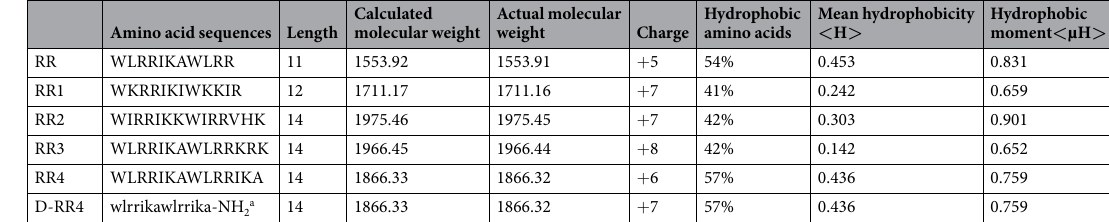
(Table 2). The reason for this minor discrepancy in antimicrobial activity between RR4 and D-RR4 against dif- ferent bacterial isolates is not clear. Previously it was reported that membrane-targeting antimicrobial peptides work without the need for receptors and therefore D isomers have similar antimicrobial activity to L isomers 17 . However, there are several studies that have reported that D isomers demonstrated different antimicrobial responses than their L isomer counterparts against different bacterial isolates. This may be due to the fact that the backbone of D and L isomers of helical AMPs, in three-dimensional space, have opposite rotations and therefore their side chains will have differing topologies 18 . A possible alternative explanation for the difference in anti- microbial activity between RR4 and D-RR4 is that P. aeruginosa and A. baumannii produce differing amounts of proteases 19–21 . P. aeruginosa secretes two major proteases, Pseudomonas elastase and an alkaline protease 22 .